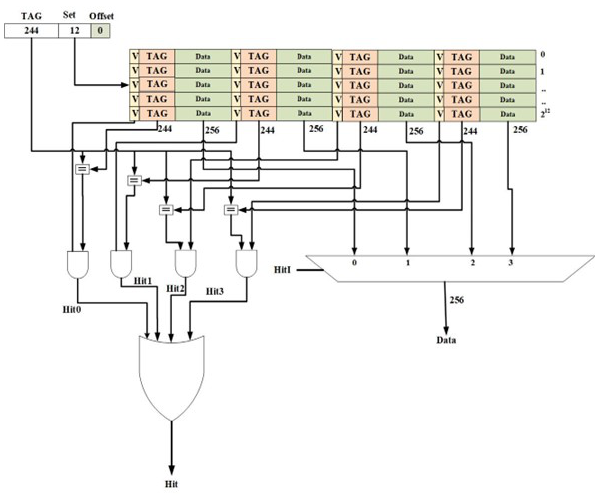
Figure 12. Layout of a 4-way set-associative cache